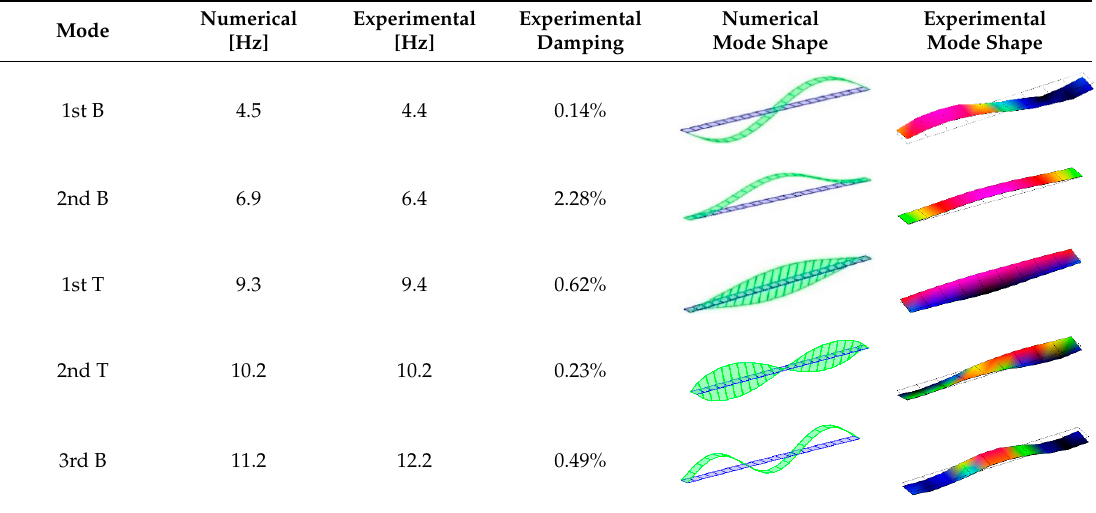
Table 1. The numerical and experimental natural frequencies and mode shapes of the bridge mock-up. Numerical Experimental Experimental Numerical Experimental Mode [Hz] [Hz] Damping Mode Shape Mode Shape